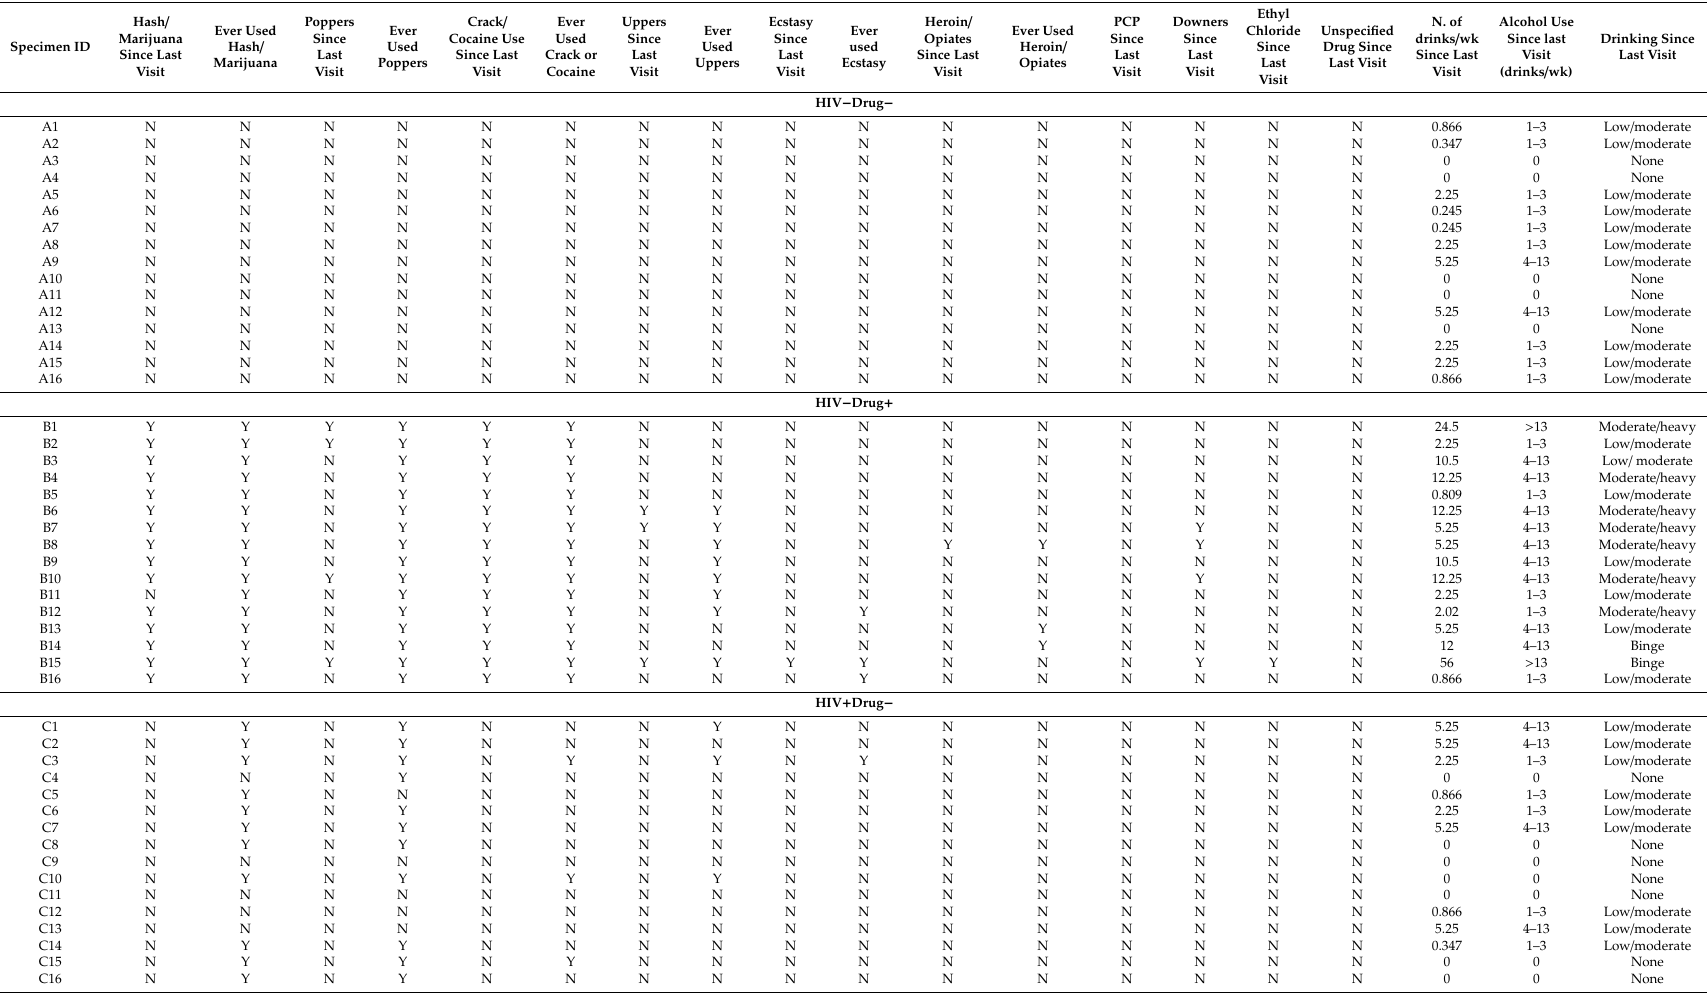
Table 1. Description of psychostimulants and alcohol use by study